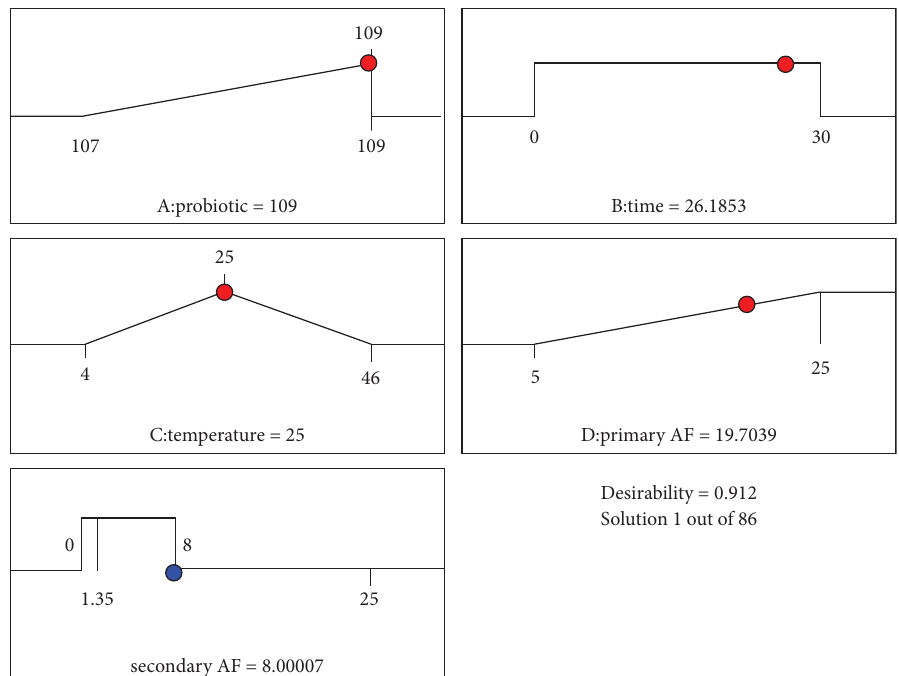
Figure 10: Optimization values of initial levels of afatoxin, probiotics, temperature, and storage time of pistachio paste on the reduction in AFB1 residue (59.4%).